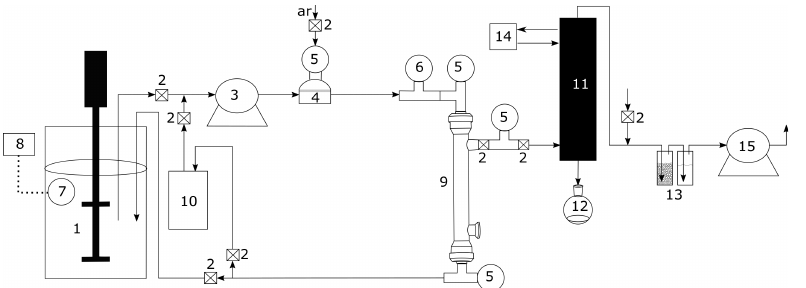
Figure 1. Schematic of the pervaporation experimental setup used in the study. (1) vessel, (2) valve, (3) peristaltic pump, (4) pulse damper, (5) pressure gauge, (6) vacuum gauge, (7) temperature sensor, (8) temperature controller, (9) membrane and module, (10) vessel, (11) Jacket Dimroth condenser, (12) product trap, (13) safety trap, (14) thermostatic bath, (15) vacuum